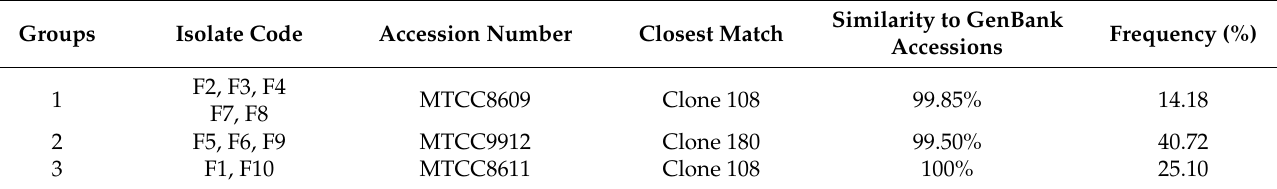
Figure 2. Internal transcribed spacer (ITS) regions of Fusarium oxysporum lycopersici isolates were amplified by polymerase chain reaction using ITS1 and ITS4 primers and the products were separated by agarose gel electrophoresis. M, 100 bp ladder; lane 1, F1 isolate; lane 2, F2 isolate; lane 3, F3 isolate; lane 4, F4 isolate; lane 5, F5 isolate; lane 6, F6 isolate; lane 7, F7 isolate; lane 8, F8 isolate; lane 9, F9 isolate; lane 10, F10 isolate; lane 11, no template control. Table 1. Molecular variability of FOL isolates.